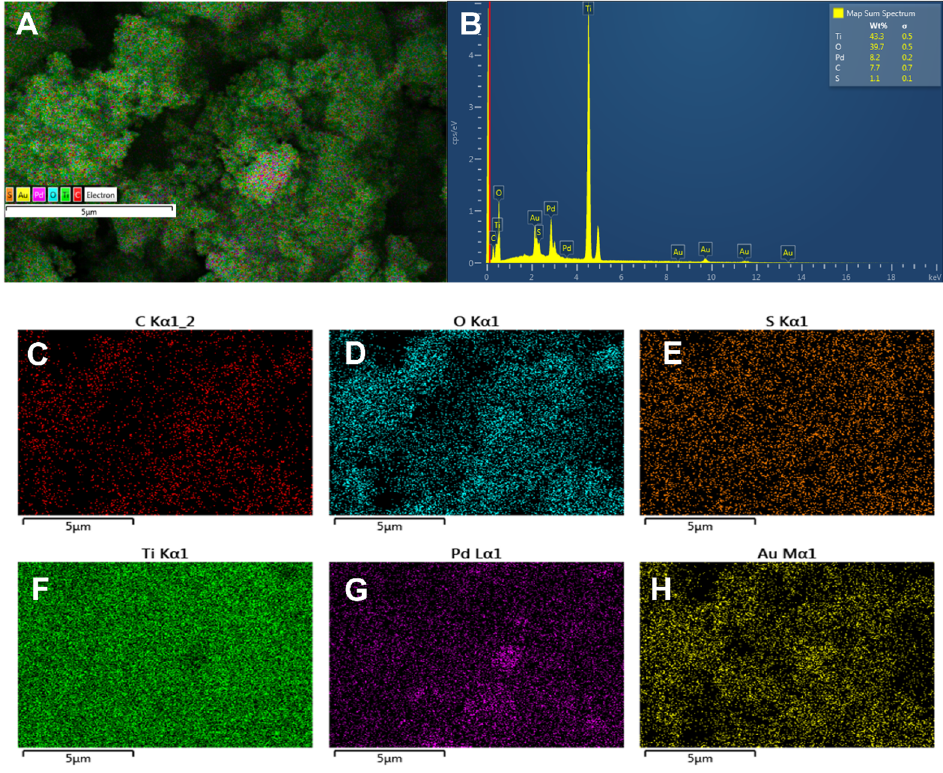
Figure 3. ( A ) EDX analysis of the PdO.TiO 2 ; ( B ) elemental and compositional analysis; ( C – H ) mapping analysis.